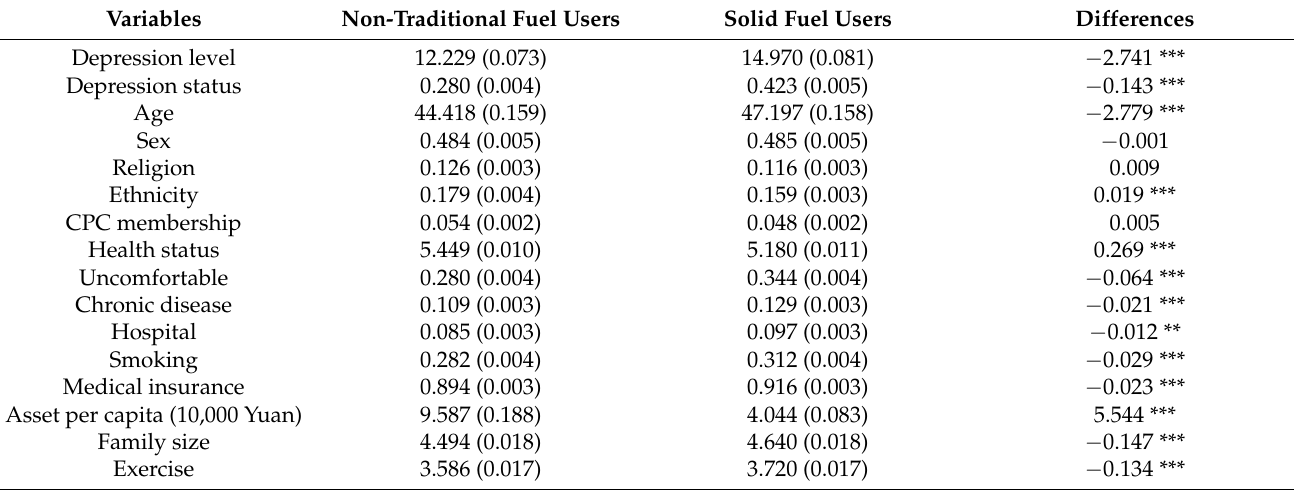
Table A1. Mean differences in characteristics between solid fuel users and non-traditional fuel users by adjusting the p -value according to sample